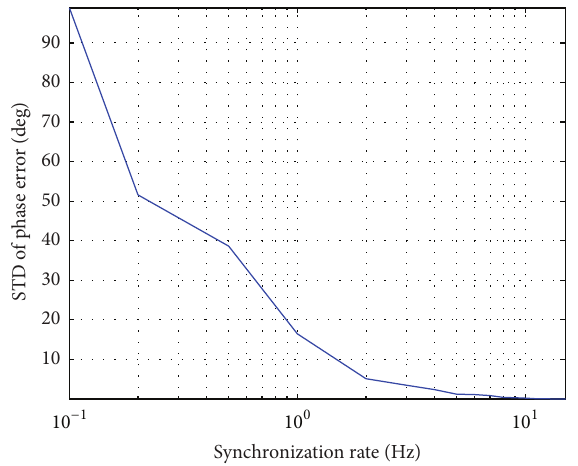
Figure 7: Prediction of phase synchronization accuracy versus synchronization repeatedly frequency